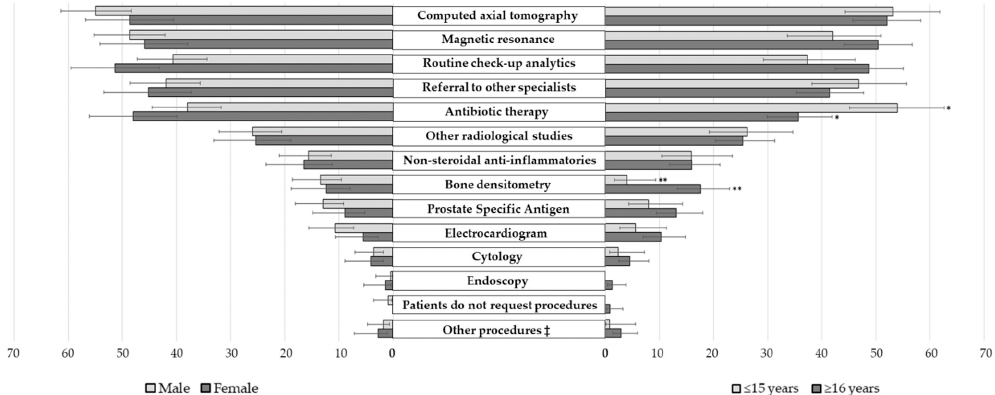
Figure 3. Frequency of patients’ unnecessary procedures requested to surgical doctors, according to the gender and experience of professionals. Percentage of professionals who indicated each reason (with the 95% confidence interval of such percentages). Each respondent could mark as many procedures deemed necessary. ‡: “Surgical treatment”, “digestive tumor markers”, “genetic studies”, “cesarean sections”, “lactose intolerance test”, “electrotherapy and thermotherapy”, “allergy tests”, and” electromyography”. * p < 0.050; ** p < 0.001.